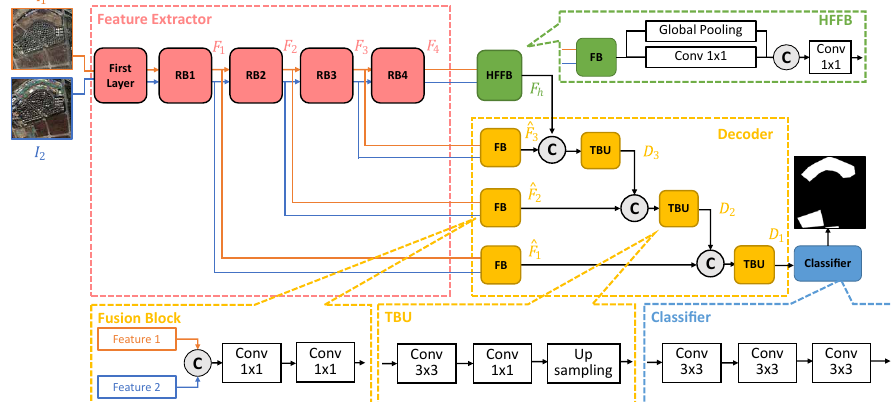
Figure 2. Illustration of the architecture of the proposed network. It mainly consists of four parts: Feature extractor (in siamese architecture), HFFB, Decoder and Pixel classifier. Table 1. Feature map